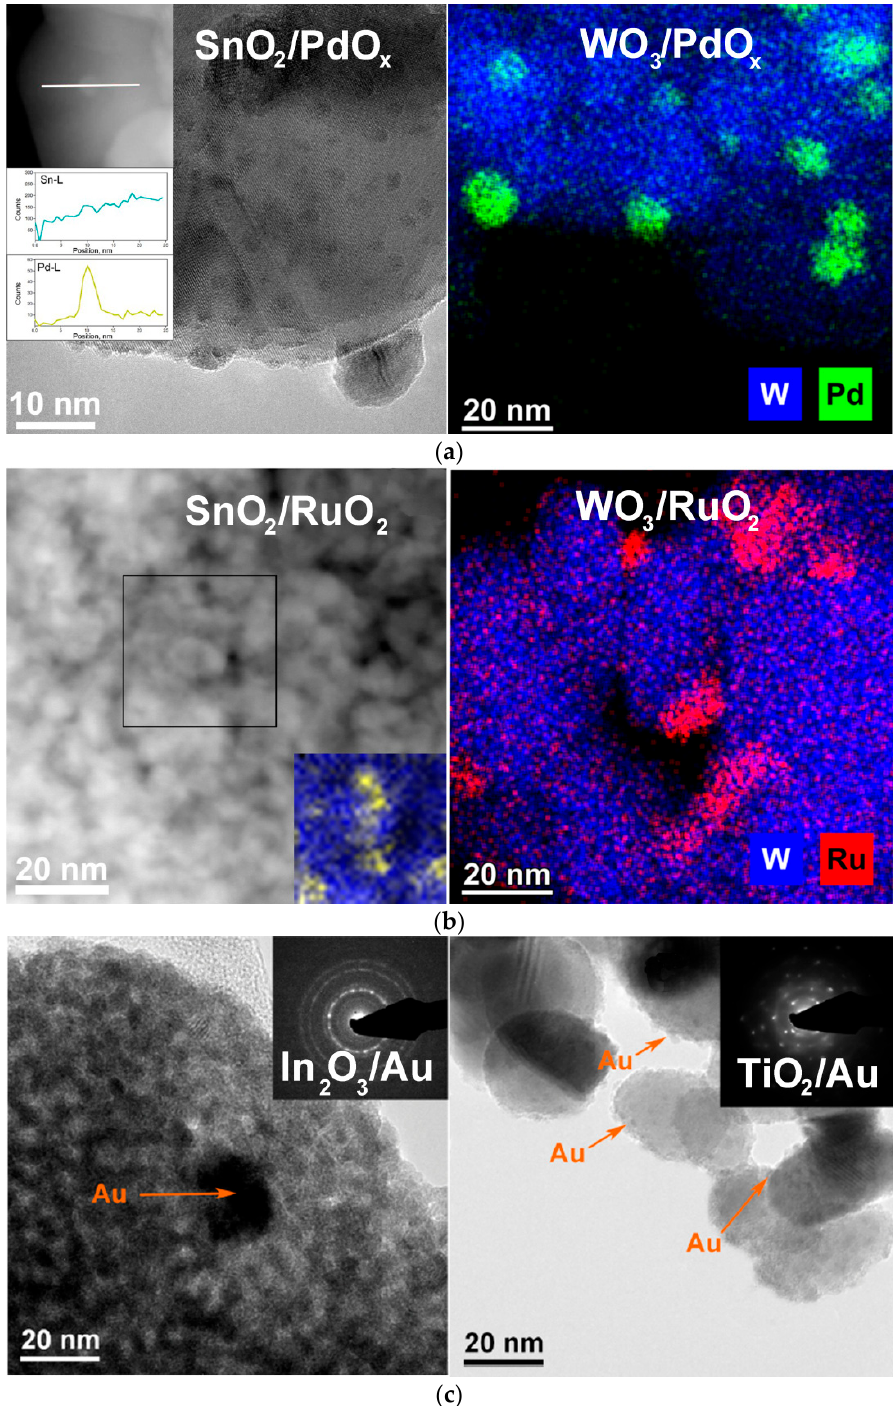
Figure 22. TEM micrographs, STEM images and EDX elemental maps of nanocrystalline SnO 2 and WO 3 functionalized by PdO x ( a ) and RuO 2 ( b ); and TEM micrographs with electron diffraction patterns of In 2 O 3 and TiO 2 functionalized by Au ( c ). Adapted with permissions from ref. [75] copyright 2018 Elsevier; ref. [78] copyright 2021 Elsevier; ref. [95] copyright 2013 American Chemical Society.